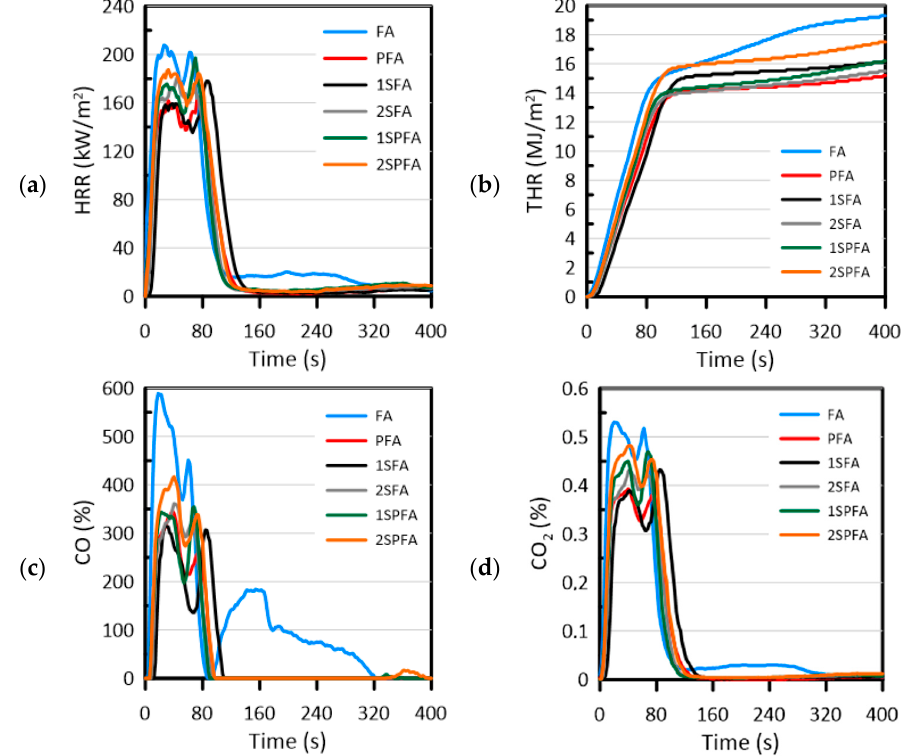
Figure 9. Charts of HRR ( a ), THR ( b ), CO ( c ), CO 2 ( d ).